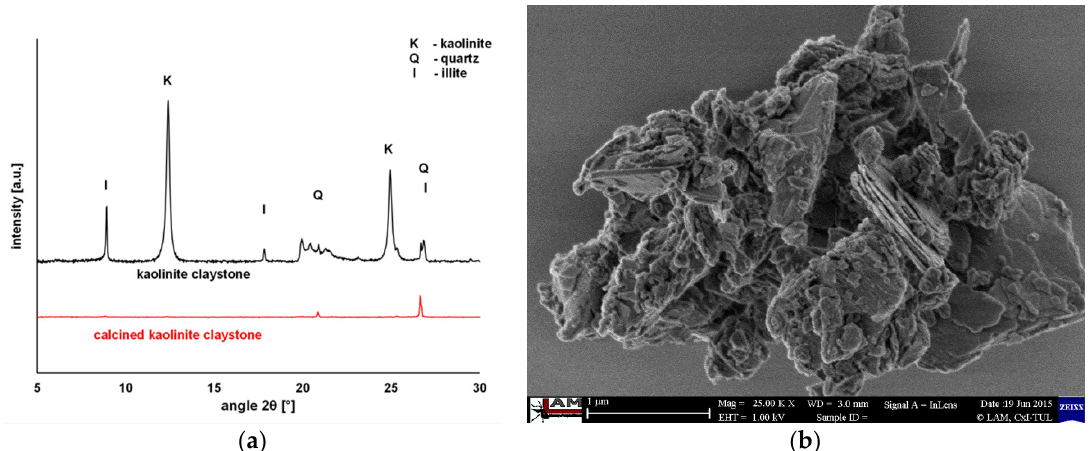
Figure 2. ( a ) XRD patterns of kaolinite claystone before and after calcination; ( b ) SEM of the metakaolin prepared from calcined kaolinite claystone. The scale bar is 1 µm long.